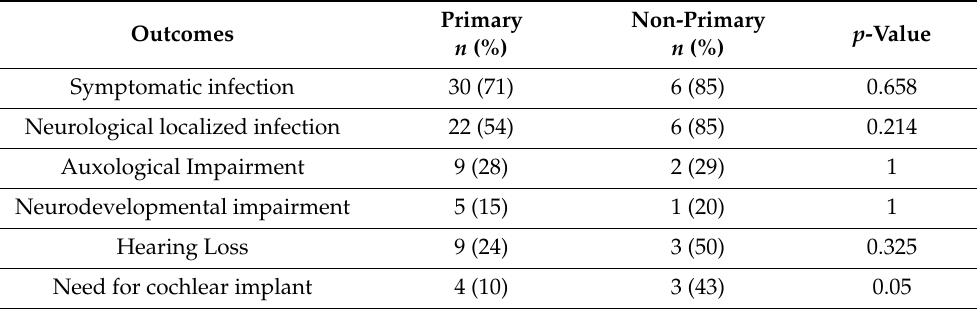
Table 5. Di ff erences between the two types of